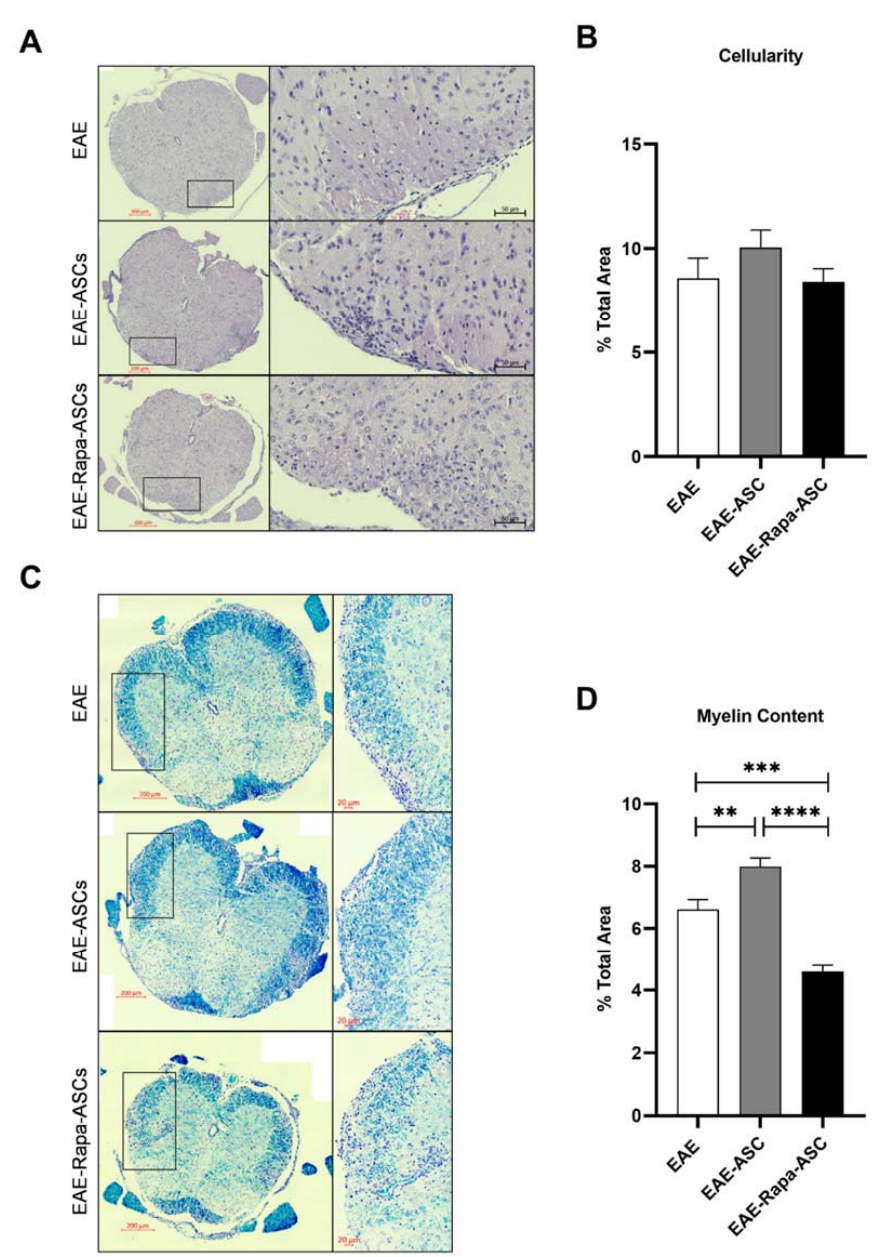
Figure 2. Rapa-ASCs result in reduced intact myelin when administered during late-stage EAE. Figure 2. Rapa ‐ ASCs result in reduced intact myelin when administered during late ‐ stage EAE. Representative images of ( A ) hematoxylin and eosin-stained and ( C ) Luxol fast blue-stained Representative images of ( A ) hematoxylin and eosin ‐ stained and ( C ) Luxol fast blue ‐ stained lumbar spinal cord sections from vehicle ‐ treated EAE (EAE), ASC ‐ treated EAE (EAE ‐ ASC) and Rapa ‐ ASC ‐ lumbar spinal cord sections from vehicle-treated EAE (EAE), ASC-treated EAE (EAE-ASC) and Rapa-ASC-treated EAE (EAE-Rapa-ASC) mice. Quantitative comparison of ( B ) cellular infiltration and ( D ) myelin content in spinal cord sections between each group ( n = 4). Quantitative data are represented as the number of positive pixels divided by the total pixels of the section. Statistical analysis was performed using a mixed e ff ects model of repeated measures analysis of variance (ANOVA) and Tukey’s post-hoc multiple comparisons test. Statistical di ff erences between the mean ± SEM of EAE and EAE-ASC are marked with ** p < 0.01; *** p < 0.001; and **** p <